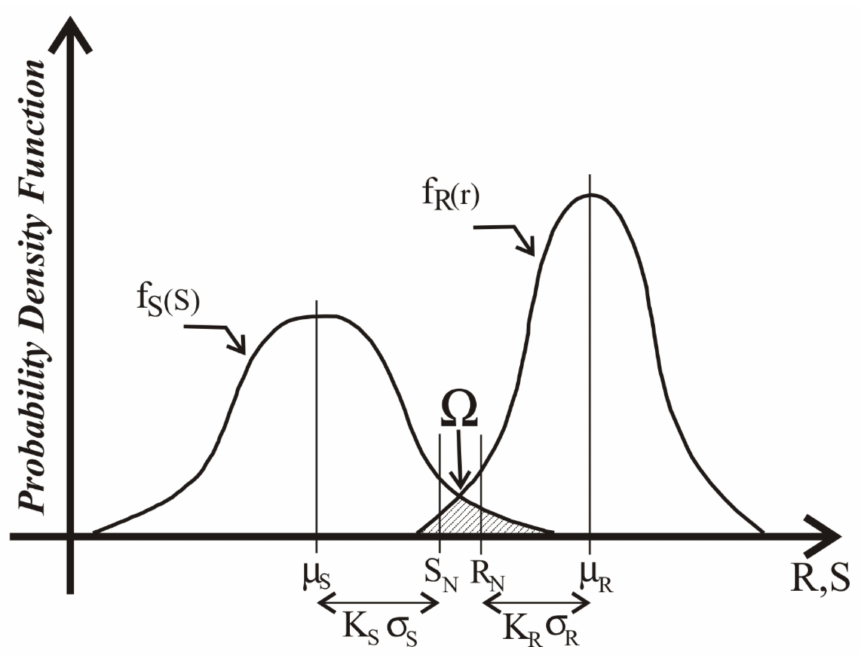
Figure 4. Illustration of risk analysis of